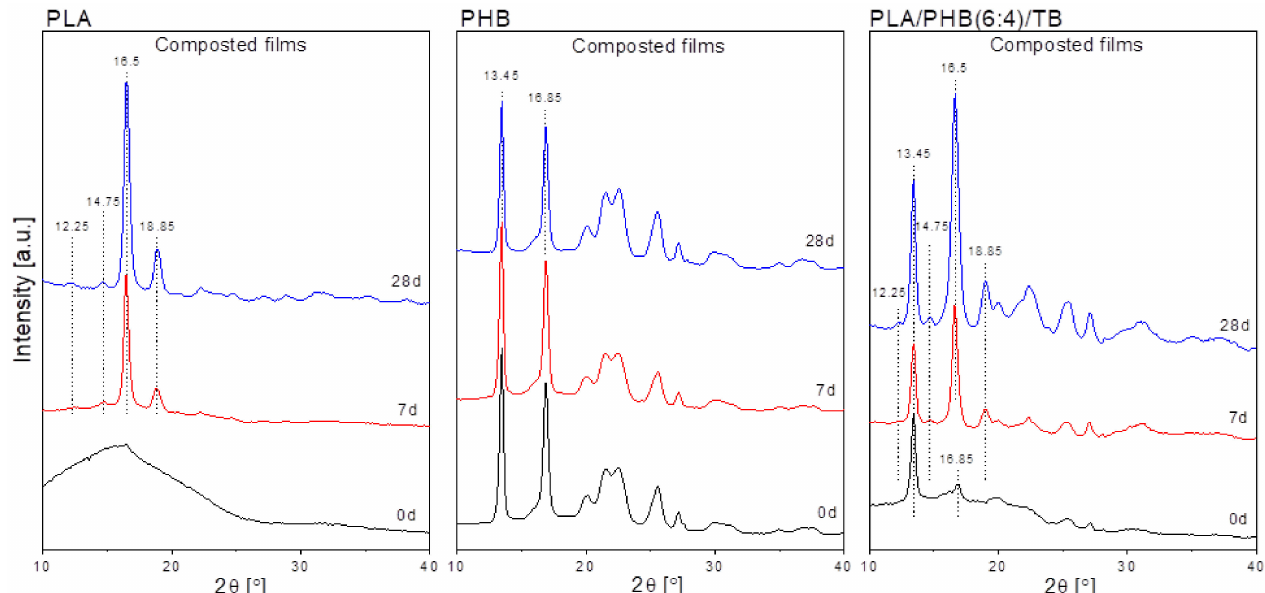
Figure 6. WAXS spectra of: PLA ( left ), PHB ( center ) and PLA/PHB(6:4)/TB ( right ) films incubated in compost for 0, 7 and 28